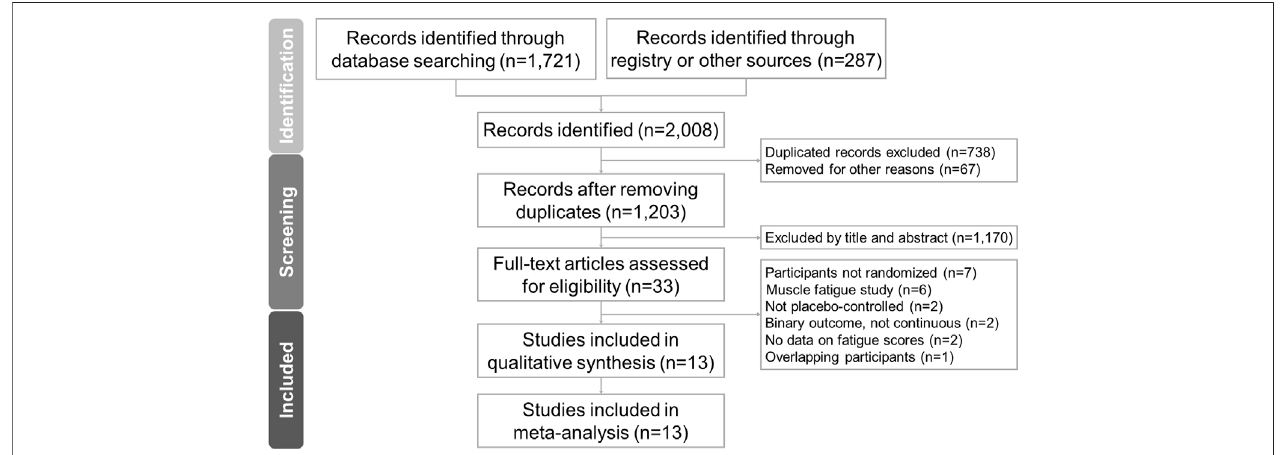
FIGURE 1 | PRISMA 2020 fl owchart for the current